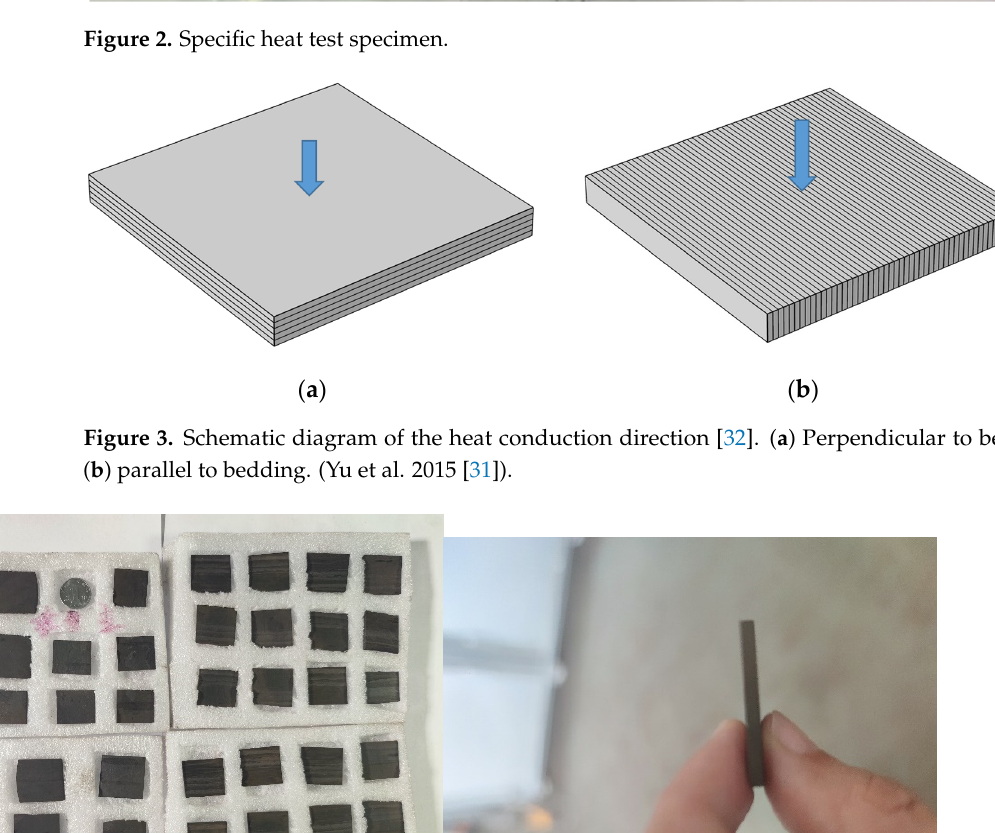
Figure 3. Schematic diagram of the heat conduction direction [32]. ( a ) Perpendicular to bedding; ( b ) parallel to bedding. (Yu et al. 2015). Figure 4. Oil shale test specimen